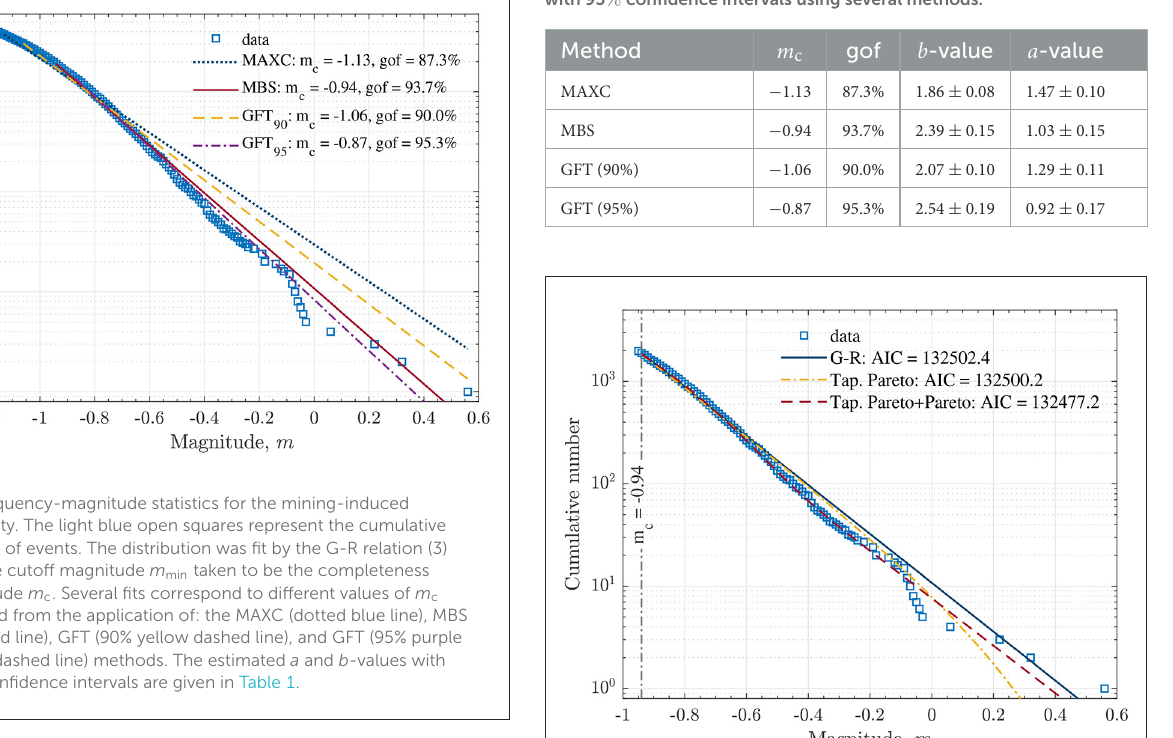
TABLE 1 The estimated magnitude of completeness m c , a and b -value with 95 % confidence intervals using several methods.